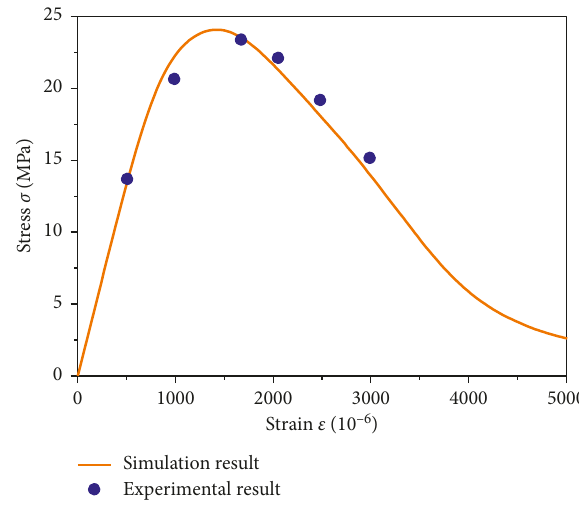
Figure 14: Comparison of macro-stress-strain curve between the numerical simulation and experimental result of Dilger et al.